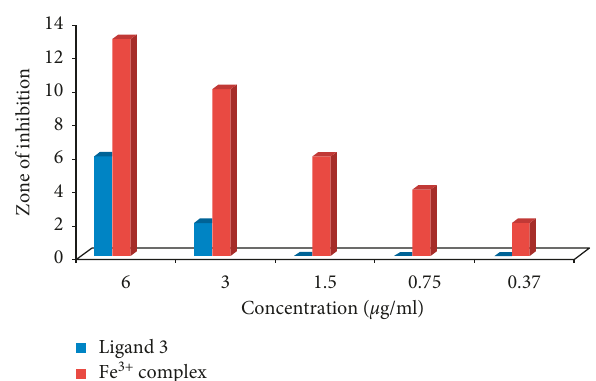
Figure 7: Antimicrobial activity of ligand 3 (L) and its Fe 3+ complex against S. albus (G +ve).